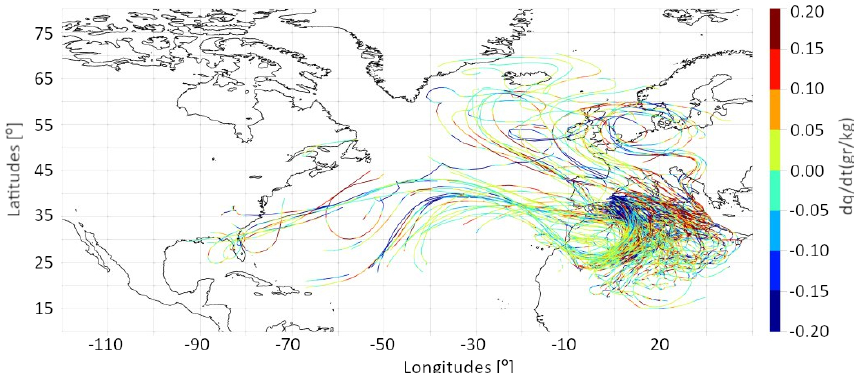
Figure 3. A period of 11d backtracking for a reduced subset of selected particles precipitating over the target area (blue in Fig. 1c) between 18:00–21:00UTC on 20 October. Moisture exchanges are represented along the particle path.